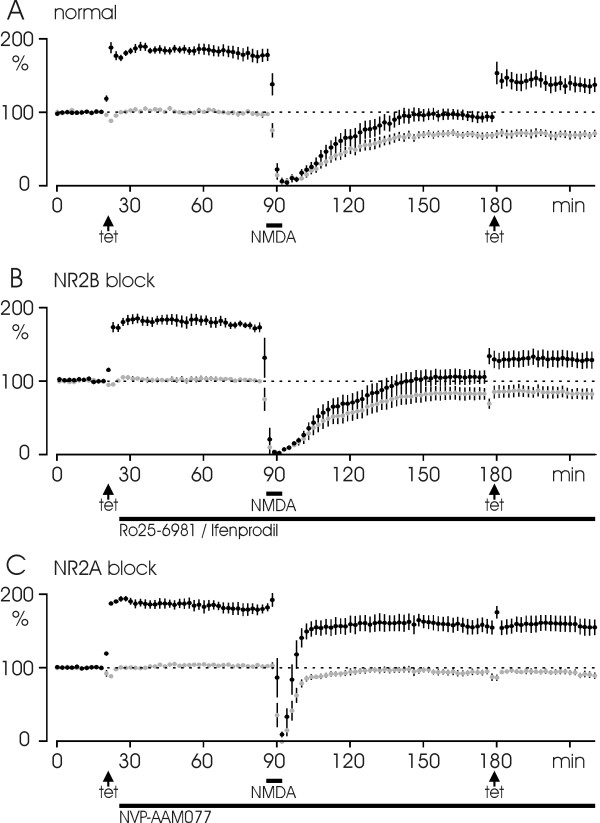
Roles of NR2B and NR2A subunits in depotentiation and repotentiation after LTP. (A) LTP is induced by three successive tetani (100 Hz, 100 impulses each) leading to a near doubling of the EPSP. Subsequent application of NMDA (30 μM, 4 min) leads to persistent depression of the control pathway (gray symbols) and depotentiation of the test pathway (black symbols). Secondary tetanization of the test pathway causes a repotentiation, lifting the test responses back to a potentiated level (n = 12). (B) and (C) show similar experiments but treated with Ro25-6981 (0.5 μM; n = 4)/Ifenprodil (3 μM; n = 2) (total n = 6) or NVP-AAM077 (0.4 μM; n = 5) shortly after LTP induction. Both depotentiation and repotentiation are preferentially attenuated by NVP-AAM077 as compared to Ro25-6981/Ifenprodil. Arrows indicate the tetani. Black bars indicate the duration of drug application.